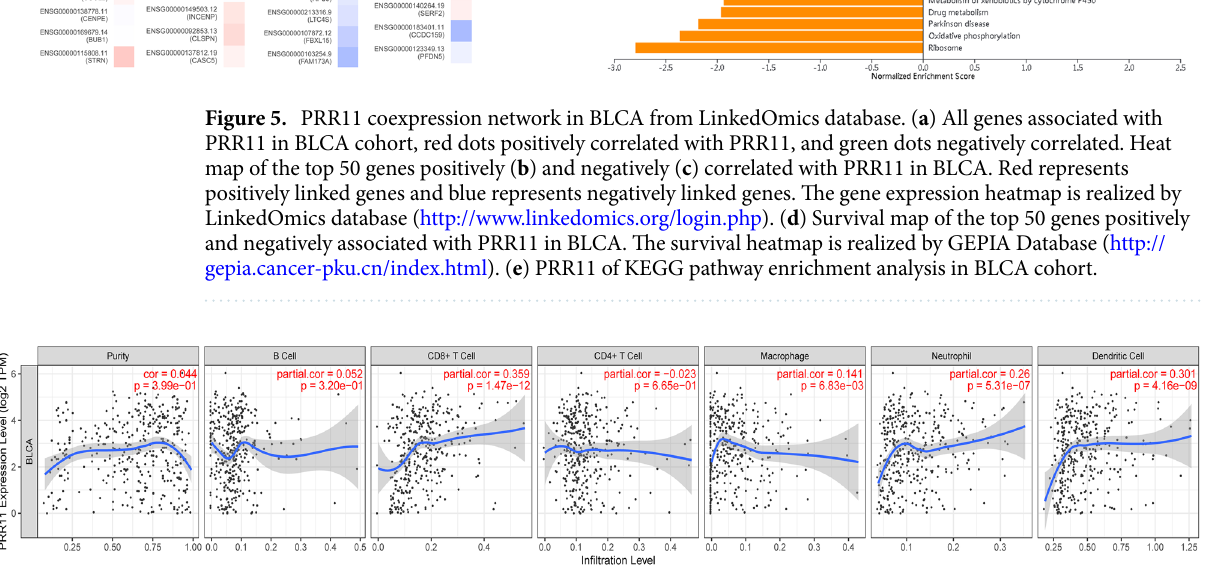
Figure 6. Correlation of PRR11 expression with immune infiltration level in